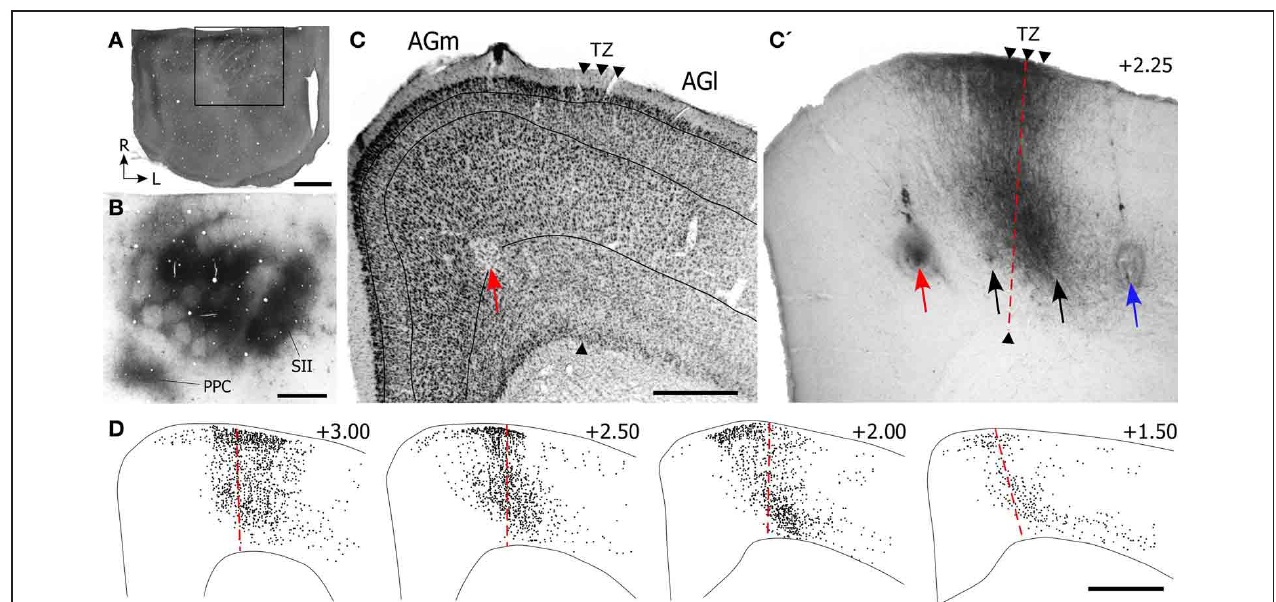
between AGm and AGl is marked by arrowheads. Arrows indicate ICMS sites for evoking peripheral movements. Red arrow indicates the site where the lowest current (10 μ A) evoked whisker twitches; black arrows indicate where higher currents (100–250 μ A) evoked whisker movements; blue arrow indicates the ICMS site (50 μ A) that evoked forelimb movements. (D) Plotted reconstructions illustrating labeled SI terminals with respect to the AGm–AGl border. Numbers indicate the distance from bregma in mm. Scale bar = 2mm in (A) ; 1mm in (B,D) ; 500 μ m in (C)